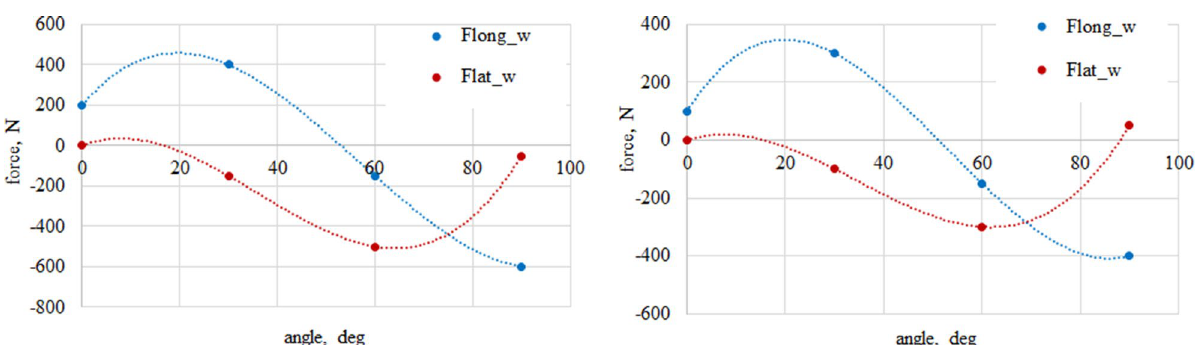
Figure 12. Values of calculated longitudinal and lateral forces depending of the slip (attack) angle—wet granite.